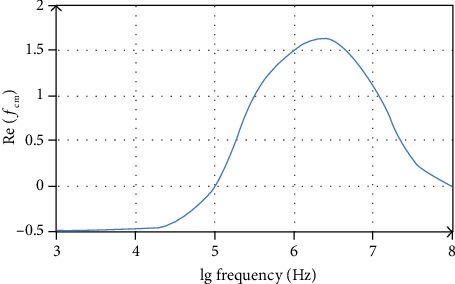
Values of Re (fCM) with electrical frequency between 1 kHz and 100 MHz.